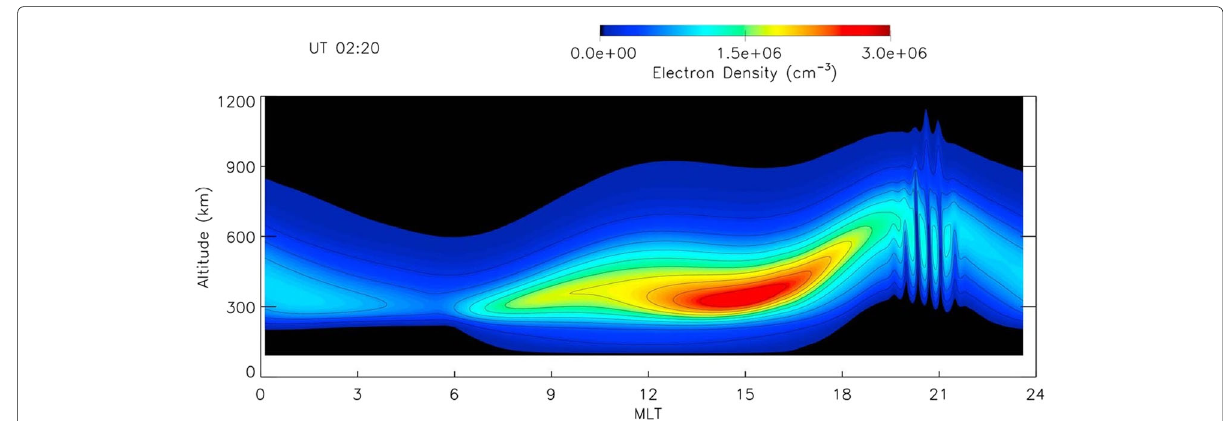
Fig. 6 EPBs produced using the global SAMI3 model. Reproduced from Huba and Joyce